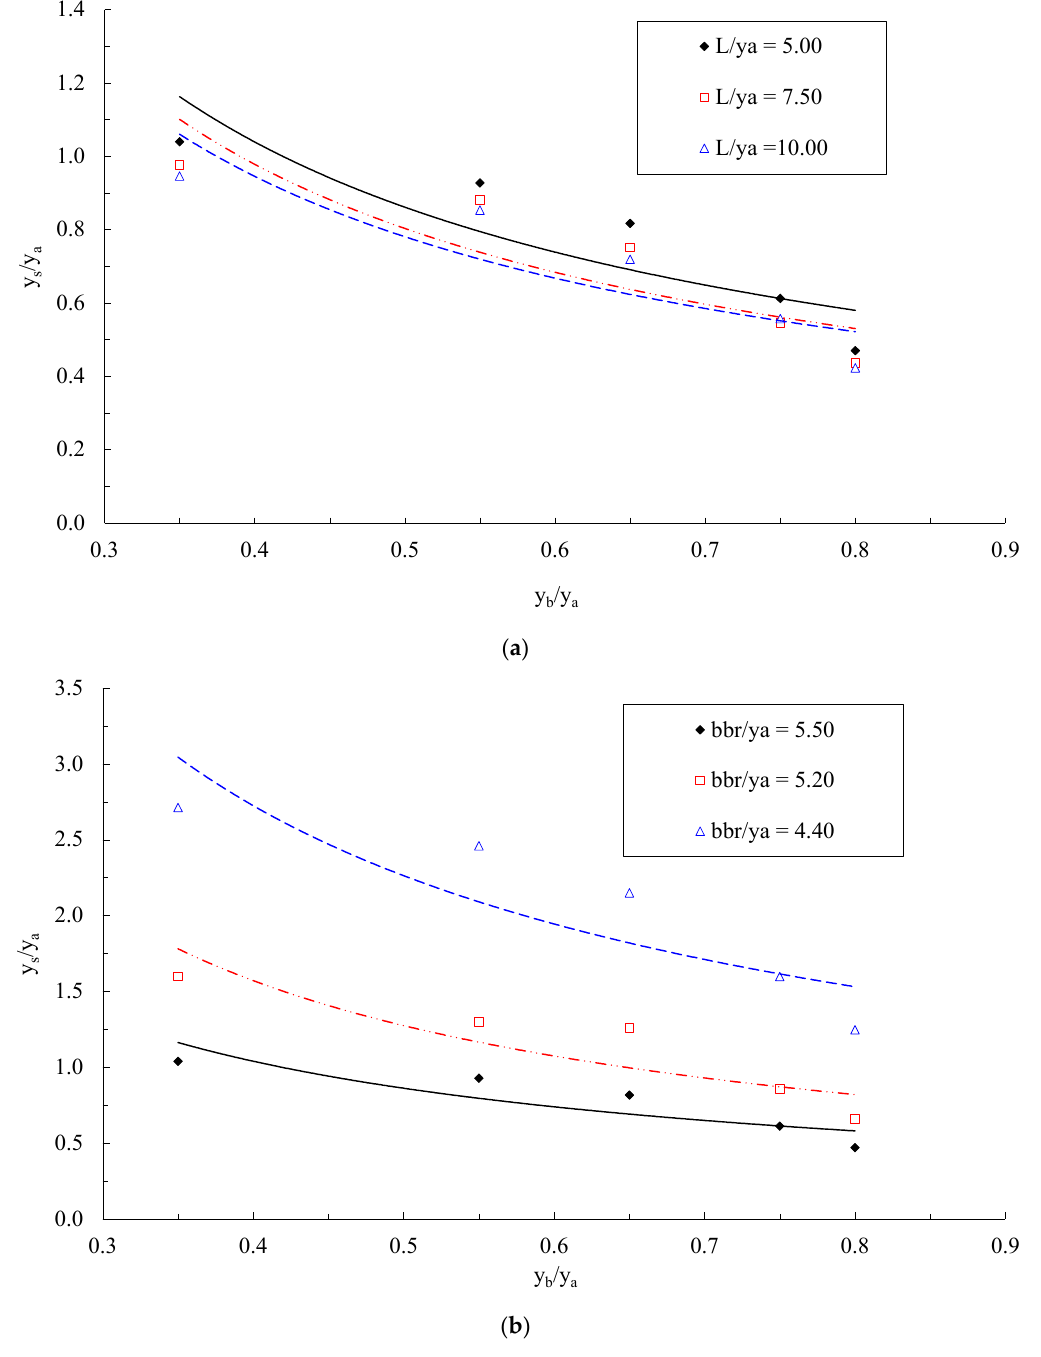
Figure 9. Relative scour depth y s / y a with the relative bridge opening y b / y a for ( a ) different relative bridge lengths ( L/y a ) and ( b ) different relative bridge widths ( b br / y a ).